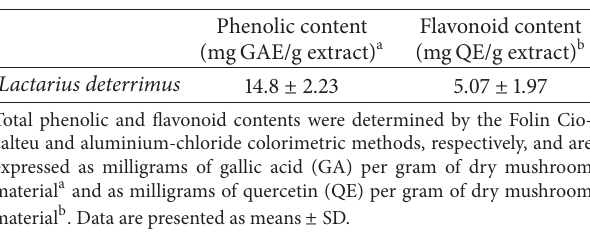
Table 1: Phytochemical constituents of the L. deterrimus